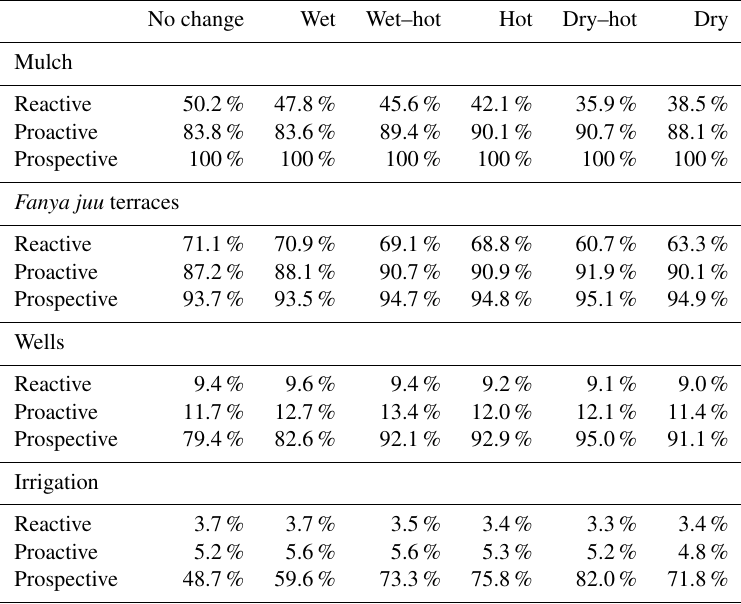
Table B1. Adoption ratio (as a share of the population) at run year 30 under different climate and intervention scenarios. Note that the model showed an adoption rate of 25% for mulch, 70% for fanya juu terraces, 9% for wells and 4% for irrigation at run year 0 (start of climate change and policy scenarios).